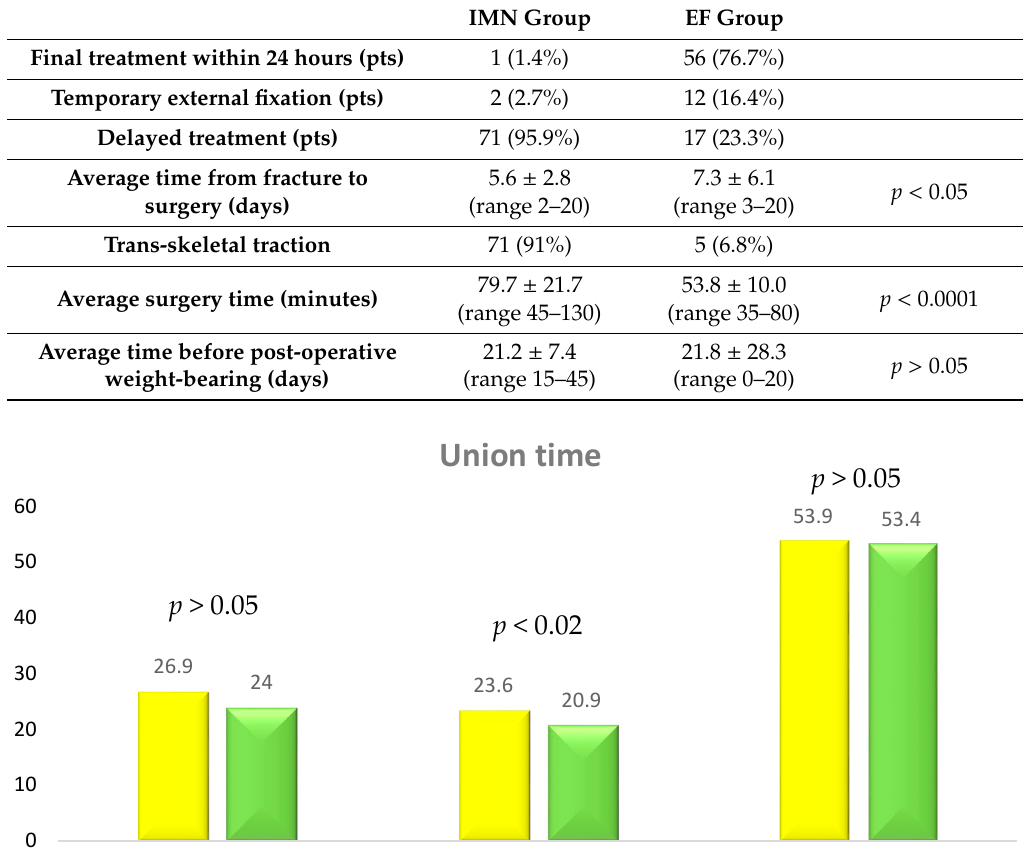
Table 2. Surgical timing: IMN group versus EF group.